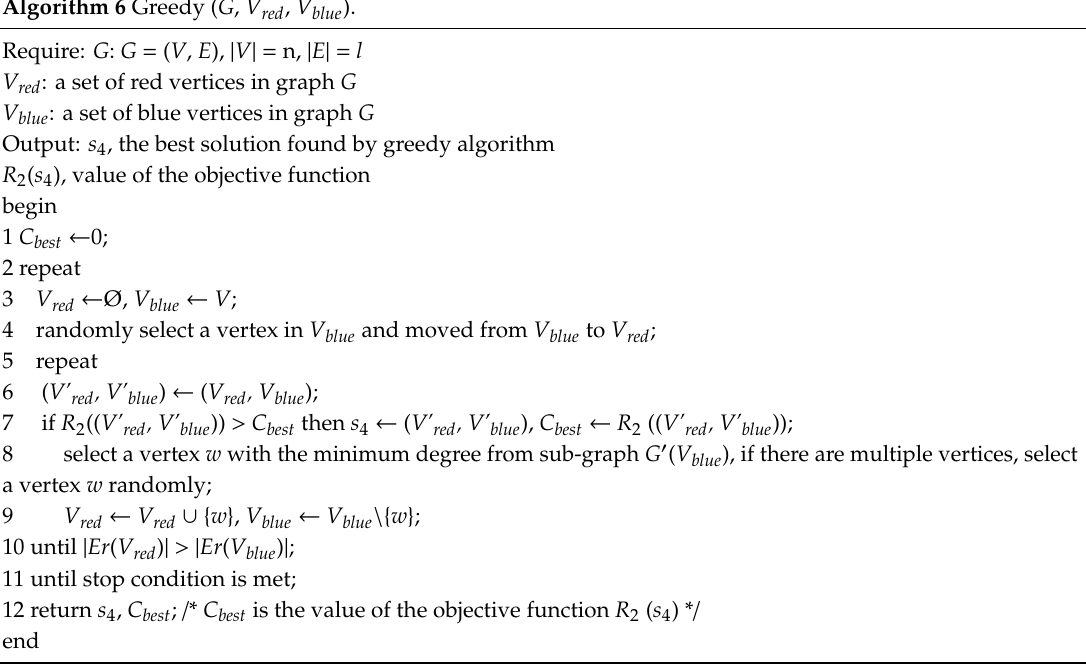
Algorithm 6 Greedy ( G , V red , V blue